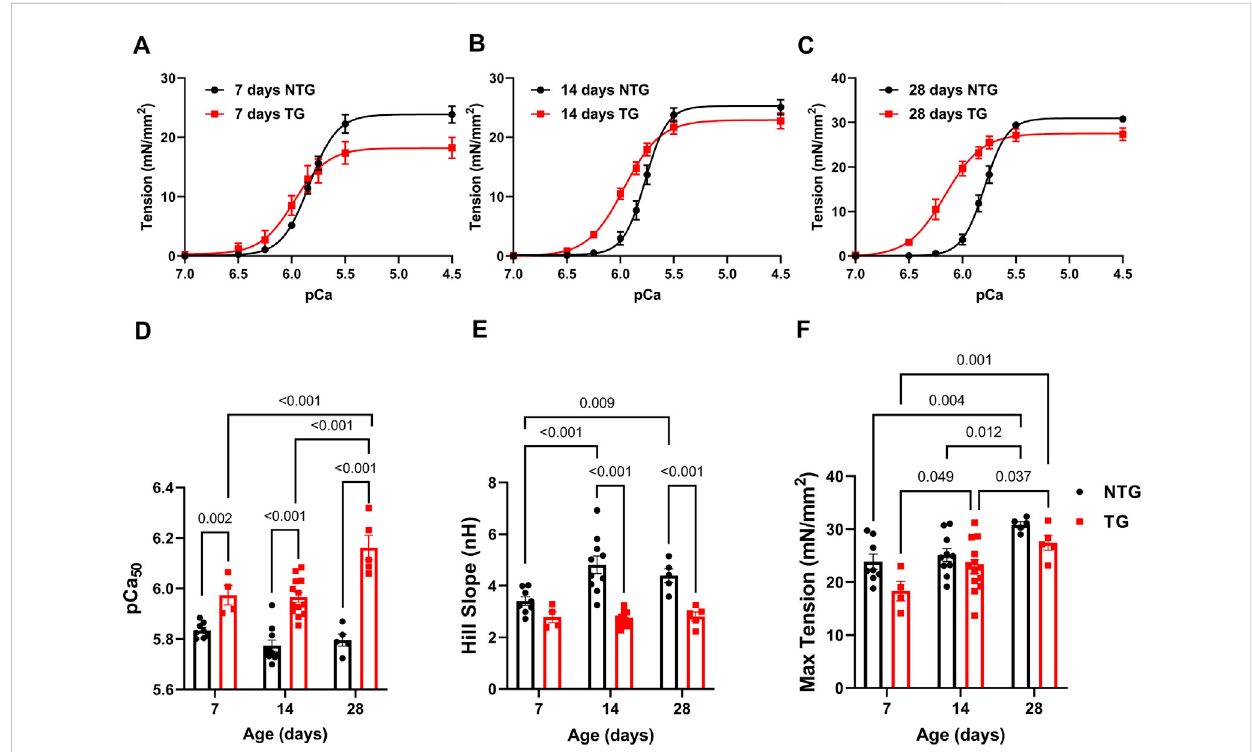
FIGURE 1 Age-dependent myo fi lament Ca 2+ response. (A) Force-Ca 2+ relation at P7, (B) at P14, and (C) at P28. (D) Summary of myo fi lament Ca 2+ sensitivity (pCa 50 ), (E) Hill slope, and (F) maximum tension. Data are presented as mean ± SEM. Data were analyzed by 2-way ANOVA followed by Fisher ’ s LSD test; N = 4 – 13. NTG, non-transgenic; TG,